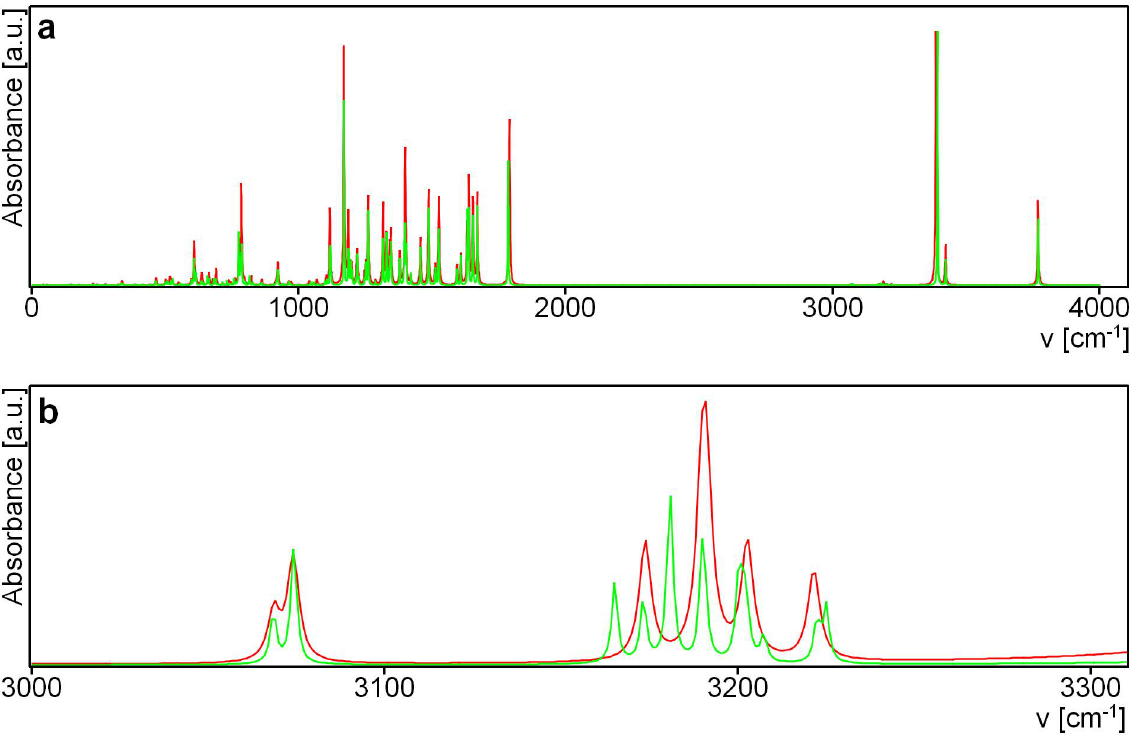
Figure 10. Theoretical IR spectra for sennidin ( a ) and sennidin ( b ). Structure 1—red, structure 7—green. When the IR spectra of structures 1 and 7 are almost identical, the differences in the spectra for 11 and 17 are more significant. The spectra obtained for sennidin C and D which arises in the IR spectrum of 11, but not of 17, at 3858 cm −1 , is the stretching of OH for the CH 2 OH group. In the spectrum of 17, this band is shifted up to 3768 cm −1 . The stretching of the OH groups linked by the hydrogen bond to carbonyl oxygen are located at 3374 cm −1 for 11 and 3365 cm −1 for 17. In the range of the stretching of aromatic C-H vibrations, the bands are located at 3189, 3175 and 3148 cm −1 , while for 17—at 3180 and 3164 cm −1 . The stretching for the C-H bonds to the central rings of both parts of anthrone is at 3072 cm −1 and 3063 cm −1 for 11, and 3072 and 3075 cm −1 for 17. In addition, the CH stretching vibrations of the CH 2 OH group are shifted from 2997 cm −1 and 2970 cm −1 for 11 to 3062 cm −1 and 3003 cm −1 for 17. In the range typical for out-of-plane OH vibrations, characteristic bands for 11 are located at 797 and 780 cm −1 and for 17—at 788, 769, 764, 487 and 473 cm −1 . In the far IR region, there are intensive out-of-plane bands for a free OH bond for 11 (242, 232, 230, 226, 193 cm −1 ) but analogous bands in the spectrum of 17 have not been detected. To check if the differences in the IR spectrum can be analyzed for structures with a similar energy, in Figure S2 (Supplementary Material) the spectra for 7, 8, 9, 10 are com- pared. For 9, a separate band at 3731 cm −1 is ascribed to the OH stretching vibrations of the carboxylic group participating in the OHO hydrogen bond linking two monoanthrone parts. At around 3400 cm −1 , stretching vibrations for double OH∙∙∙O to carbonyl for all of the analyzed structures are located, but in 9 those bands are shifted compared with the other structures. In the region of stretching of carbonyl C=O groups, two bands for two COOH groups are present. As regards structures 7 and 8, both carboxyl groups are free and those bands are located at 1786 and 1784 cm −1 for 7 and at 1795 and 1785 cm −1 for 8. In the case of 9 and 10, one of the carboxylic group is connected to the oxygen of another monoanthron and, depending on the hydrogen bond strength, these bands are shifted to 1830 and 1786 cm −1 in 9 and 1818 and 1788 cm −1 in 10.